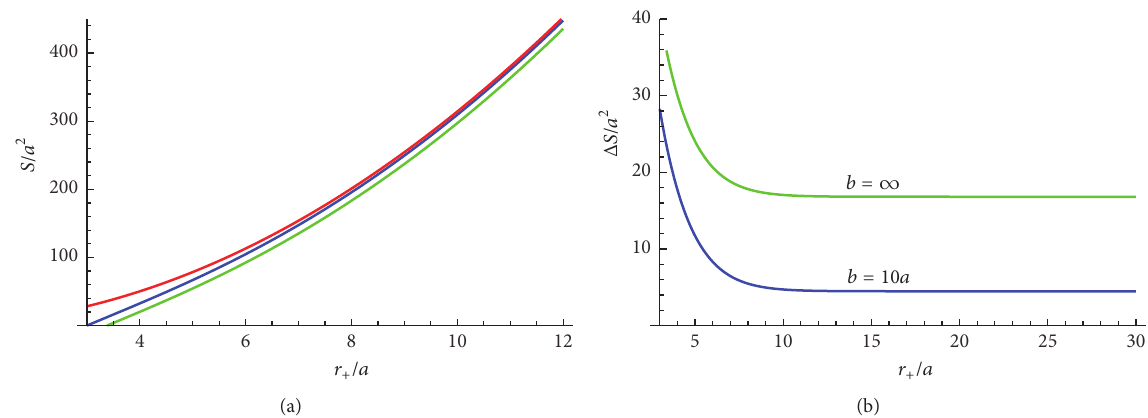
Figure 7: Plots of the entropy 𝑆 (a) and of Δ𝑆 ≡ 𝑆 − 𝜋𝑟 2 + (b) with respect to 𝑟 + . The red curve in the left diagram corresponds to the entropy 𝜋𝑟 2 + of the ordinary Schwarzschild-AdS situation; the blue and green curves in both diagrams correspond to the cases of respectively.